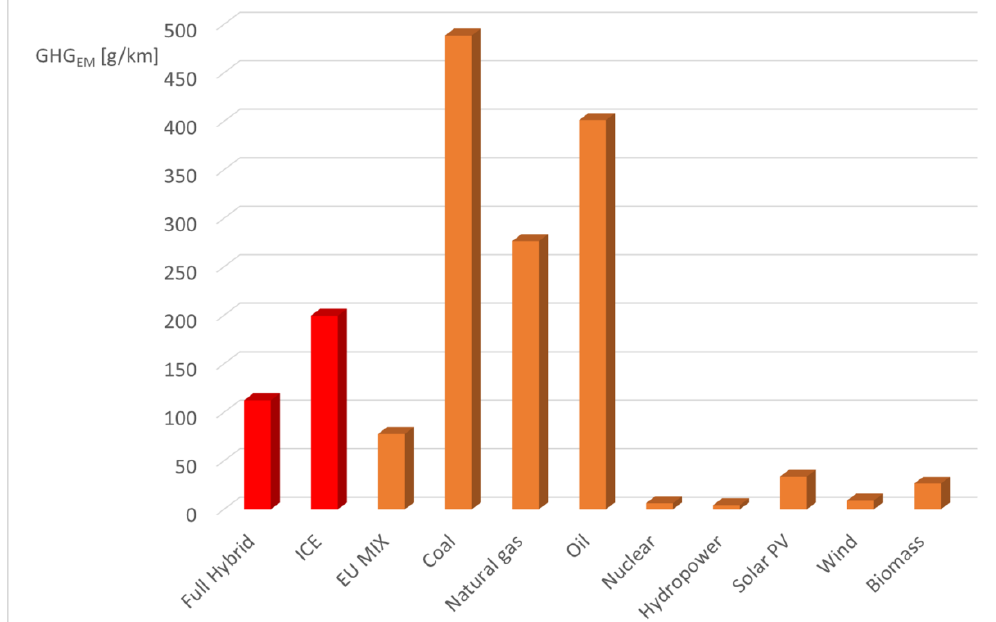
Figure 13. GHG emission of BEV for electricity produced by several energy sources.